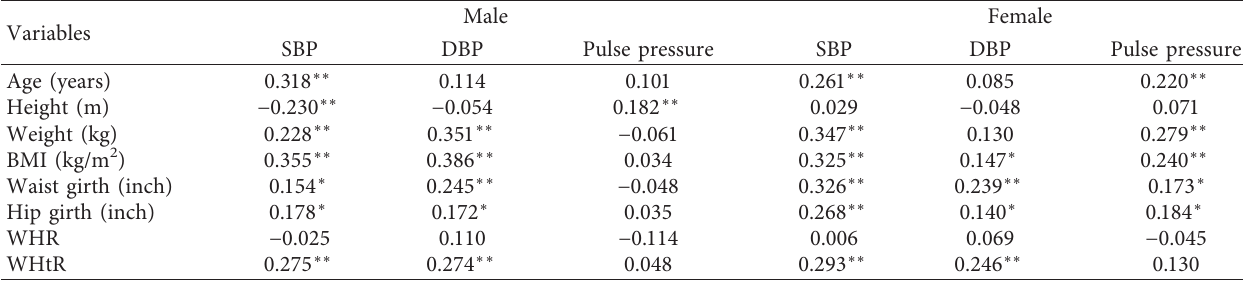
Table 1: Pearson correlation coefficients of the anthropometric and blood pressure parameters of male and female rural dwellers of Afikpo community, Ebonyi State, Nigeria.